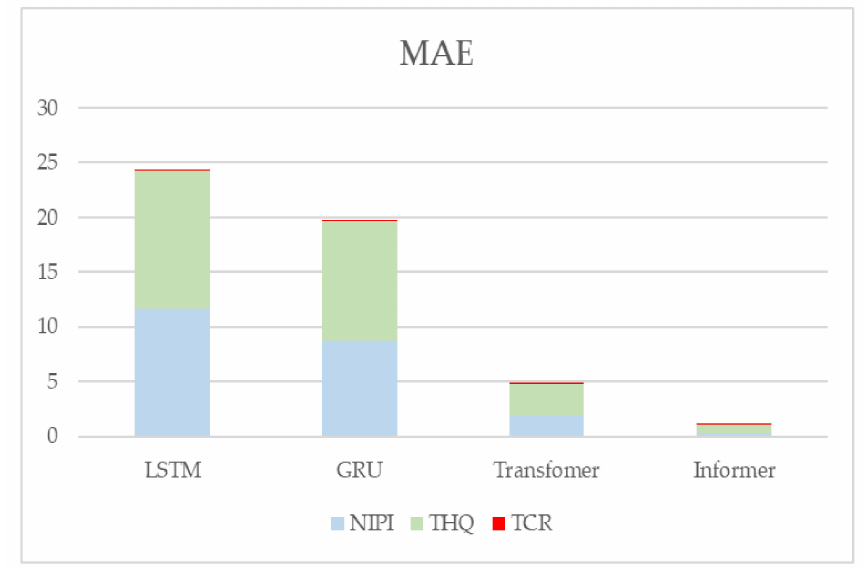
Figure 17. Predictive evaluation metric MAE for NIPI, THQ, and